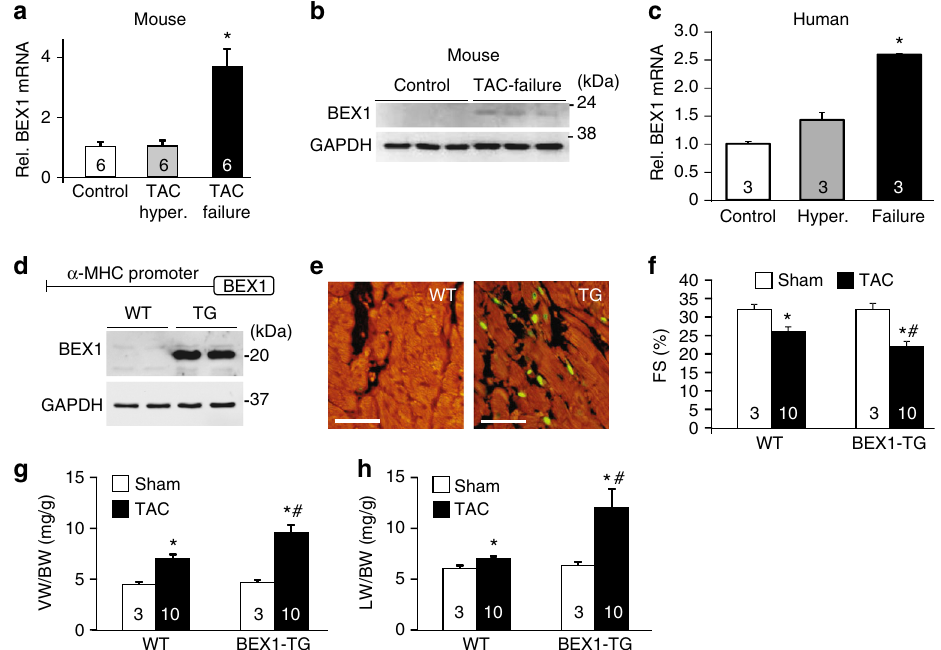
Fig. 1 BEX1 is induced in heart failure and is deleterious. a RT-PCR for BEX1 mRNA levels in hearts from mice subjected to sham surgery (Control), 2 weeks pressure-overload (TAC Hyper.) or 8 weeks pressure-overload (TAC, Failure). b Western blot for BEX1 protein expression in cardiac extracts from mice subjected to sham surgery (Control) or 8 weeks pressure-overload (TAC Failure). GAPDH was used as loading control. Molecular weight scale is shown on the right in kiloDaltons. c RT-PCR for BEX1 mRNA levels in human heart samples from controls, hypertrophic subjects (Hyper.) or heart failure subjects (Failure). d Generation of BEX1 transgenic (TG) mice and schematic of BEX1-TG construct (upper) and western blot analysis of BEX1 expression in hearts from wild-type (WT) controls or BEX1-TG mice (lower). Molecular weight scale is shown on the right in kiloDaltons. e Immuno fl uorescence staining for BEX1 (green) and α -actinin (red) in heart histological sections from WT and BEX1-TG mice. Original magni fi cation 200×. Scale bars are 25 µ m. f Echocardiographic analysis of fractional shortening (FS%) in WT control and BEX1-TG mice subjected to sham or 10 weeks of TAC. g , h Ventricular weight to body weight ratio (VW/BW) and lung weight to body weight ratio (LW/BW) from WT control and BEX1-TG mice subjected to sham or 10 weeks of TAC. * P < 0.05 vs. sham; # P < 0.05 vs. WT TAC. P values are one-way ANOVA with Bonferroni correction. Number of mice analyzed is shown in the bars of each graph. All error bars represent